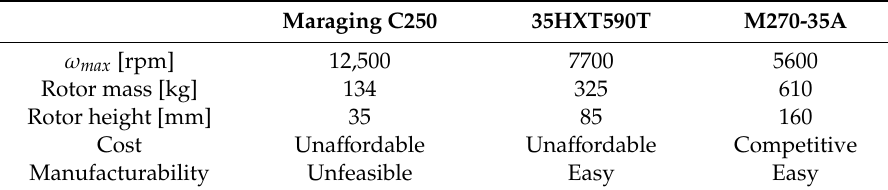
Table 3. Rotor material trade-off results.